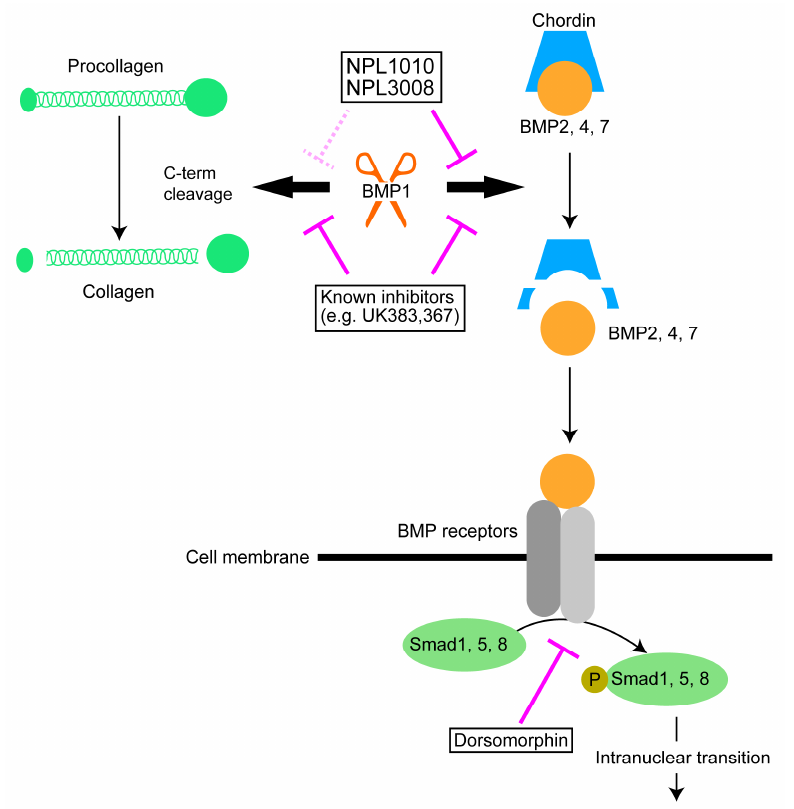
Figure 7. Hypothetical model of NPL1010 and NPL3008 function. NPL1010 and NPL3008 selectively inhibit BMP1-dependent Chrd cleavage and in- hibit BMP signaling in a Chrd function-dependent manner. Known inhibitors (e.g., UK383,367) inhibit cleavage of both Chrd and collagen. Dorsomorphin blocks the phos- phorylation of Smads and inhibits BMP signaling. The high substrate selectivity of NPL1010 and NPL3008 over UK383,367 may suggest that NPL1010 and NPL3008 do not inhibit the enzymatic activity of BMP1 itself but in- stead interfere with the interaction between BMP1 and Chrd. According to previous stud- ies, the catalytic domain and CUB1 domain are required for Chrd cleavage but are not sufficient for procollagen cleavage; the CUB2 domain of BMP1 is required for procollagen cleavage [45]. Differences in the substrate recognition mechanism might contribute to de- termining the selectivity of NPL1010 and NPL3008 for Chrd. In addition, a previous struc- tural analysis suggested that the CUB1CUB2 (C1C2) fragment of procollagen C-proteinase enhancer-1 (PCPE-1) binds to the C-propeptide trimer of procollagen III and pulls the procollagen chain toward C1C2. Then, the procollagen chain may enter the active site of the BMP1 catalytic domain, where the P1′ residue Asp interacts with Arg182 in the S1′ pocket in close proximity to the essential Glu94 and the catalytic water molecule bound to the active site zinc ion [46]. However, PCPE-1 does not enhance BMP1-dependent Chrd cleavage [45]. In addition, the putative interaction site for NPL1010 and NPL3008, com- prised of BMP1 Asn128/Thr156/Phe157, seems to differ from that between BMP1 and pro- collagen [46]. Our interaction simulation demonstrated that the Chrd C-terminal cleavage site is located in close proximity to Thr156/Phe157 of BMP1. Therefore, Thr156/Phe157 may be required for the interaction between BMP1 and Chrd but not for the interaction between BMP1 and procollagen. These differences may contribute to the selectivity of NPL1010 and NPL3008, although future studies are needed to validate this model. Our simulation results suggest that NPL1010 and NPL3008 might interact with the putative Chrd-interacting site of the BMP1 catalytic domain. Therefore, NPL1010 and NPL3008